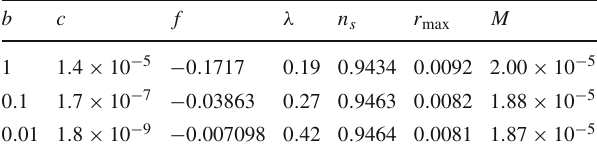
Table5 Theparameters c , f ,λ forthethreevaluesof b and (cid:17) N 2 = 20, and the corresponding inflationary predictions. The M is in the Planck